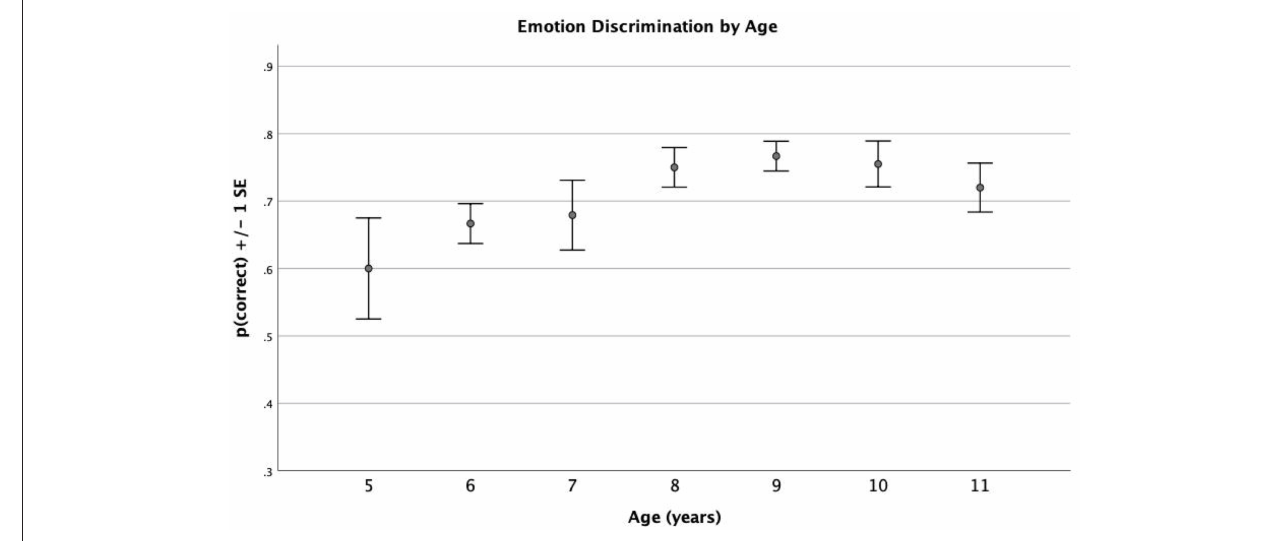
FIGURE 1 | Proportion of correct emotion detections by the age of children.